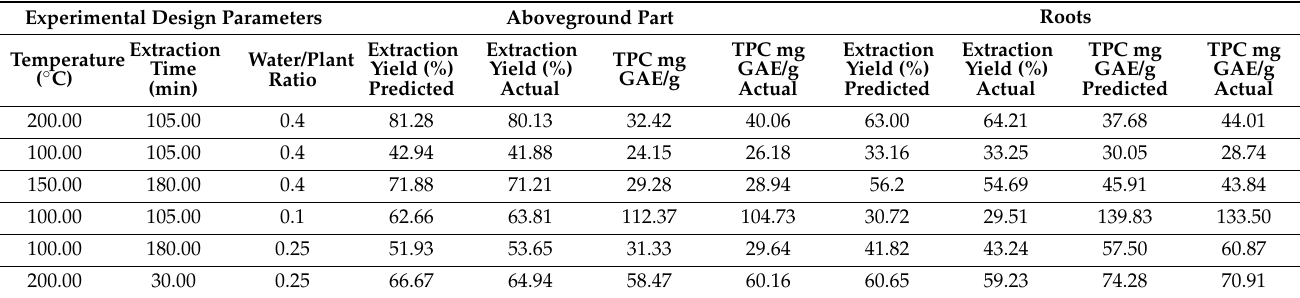
Table 1. The actual and predicted responses for the extraction yield and total phenol content, based on the 3-factor and 3-level Box–Behnken